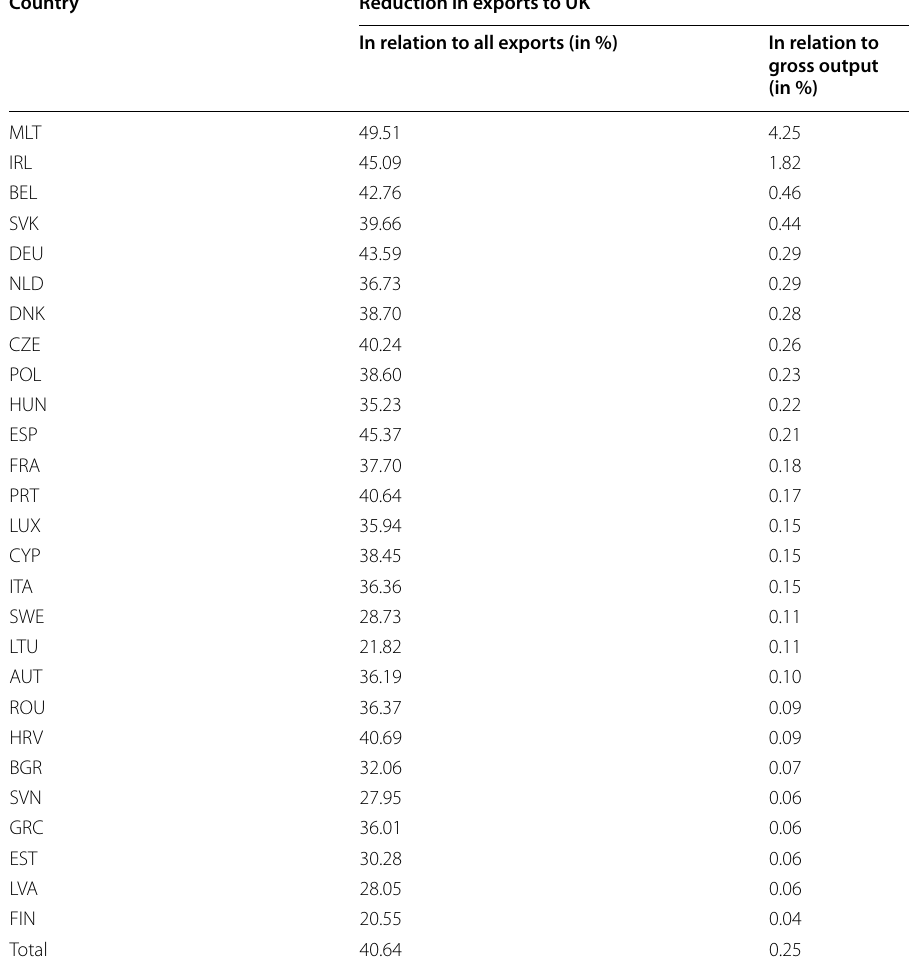
Country Reduction in exports to